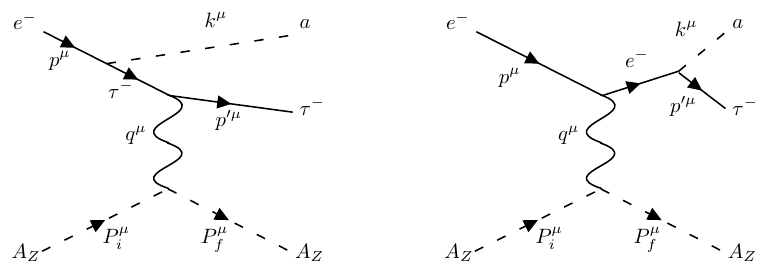
Figure 1 . The diagrams which contribute to the process eA Z → τA Z a , where A Z is the ion